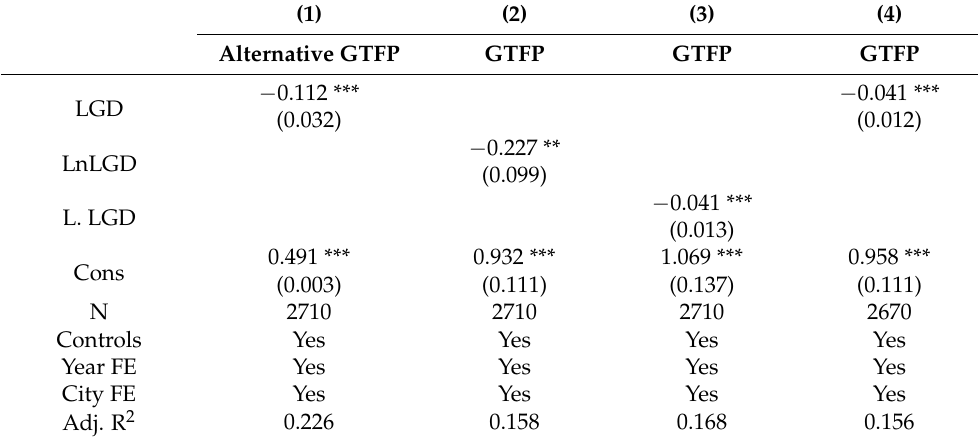
Table 4. Robustness